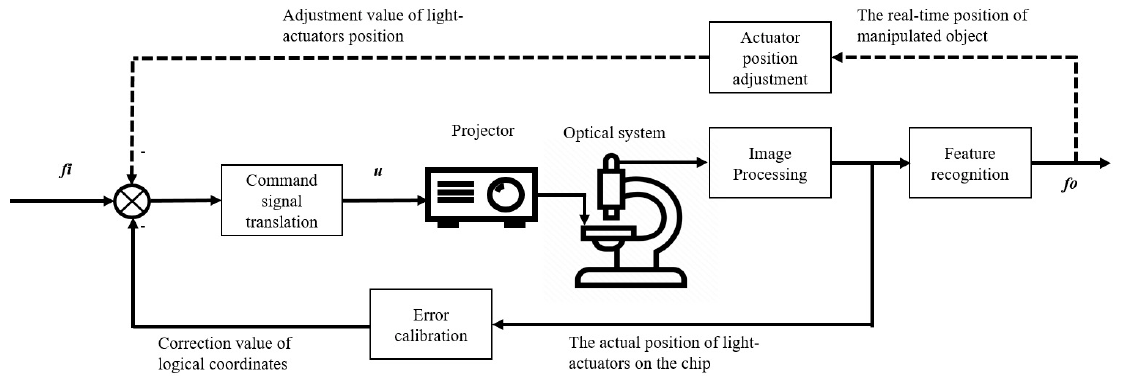
Figure 4. The schematic of image-based control system: input signal f i represents the logical coordinates of the light-actuators used to control the targeted object; output signal f o represents actual coordinates of targeted object on the chip.